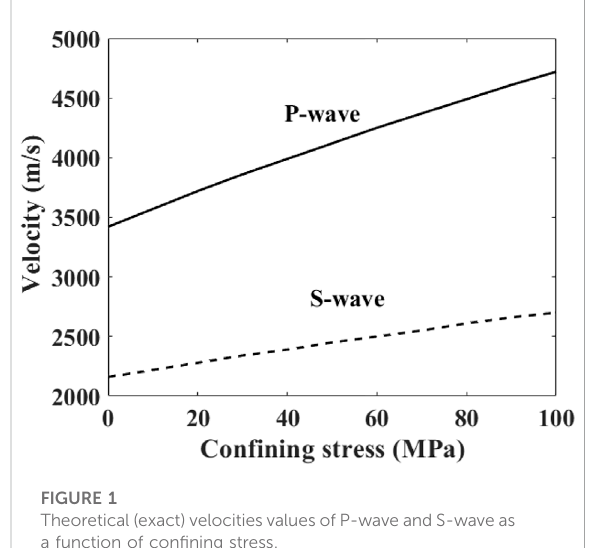
FIGURE 1 Theoretical (exact) velocities values of P-wave and S-wave as a function of con fi ning stress.